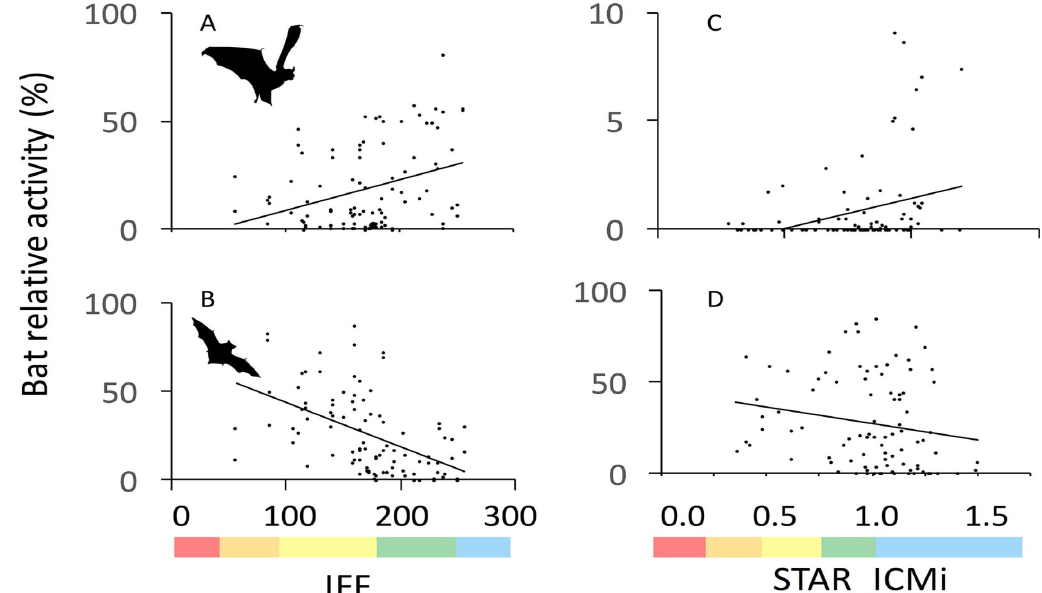
Figure 1. In a study carried out in Italy, bat communities showed significant responses to river quality. The figure shows the relationship between % activity for groups of bat species and the two bioindication indices. ( C ) is a group characterised by similar echolocation calls made of two genera ( Nyctalus and Eptesicus ) which were not separated for the purpose of the study; ( A ), ( B ), and ( D ) were groups made by associating species that showed similar responses (“shopping basket” approach) to improve bioindication performances. ( A ) = Pipistrellus pipistrellus + Myotis emarginatus + M. nattereri + Nyctalus/Eptesicus serotinus + Barbastella barbastellus ; ( B ) = Miniopterus schreibersii/Pipistrellus pygmaeus + P. kuhlii ; ( C ) = Nyctalus/Eptesicus serotinus ; and ( D ) = M. schreibersii/P. pygmaeus + M. daubentonii/capaccinii . The Fluvial Functionality Index (IFF) is shown on the left, while the macroinvertebrate-based STAR_ICMi index is on the right. River-quality ranges (increasing from left to right) associated to index values are shown below the plots as follows: red = bad, orange = poor, yellow = moderate, green = good, blue = excellent. Reprinted from [18]. Copyright (2018), with permission from